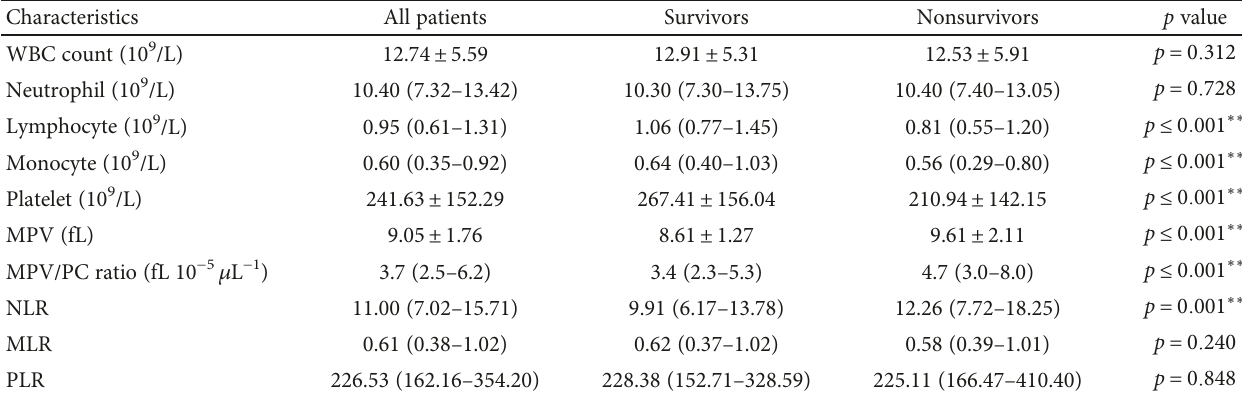
Table 2: Laboratory characteristics of all patients according to